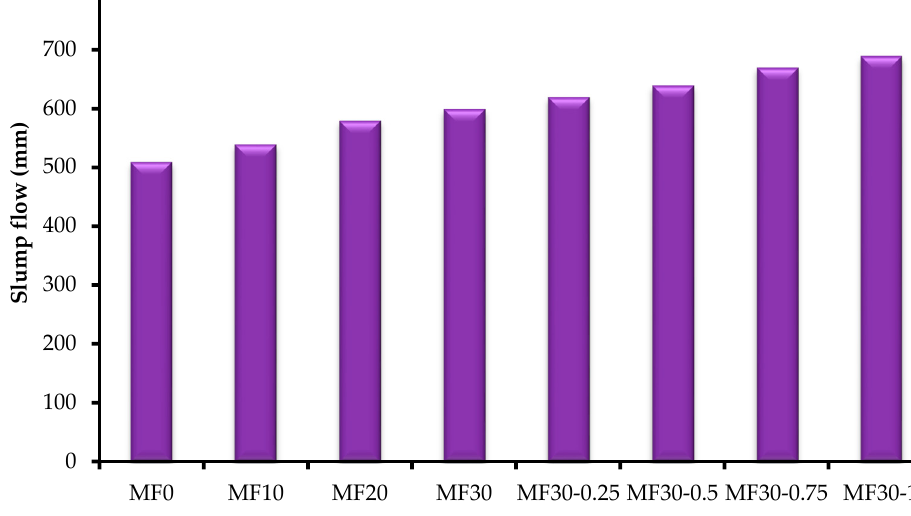
Figure 3. Slump flow.